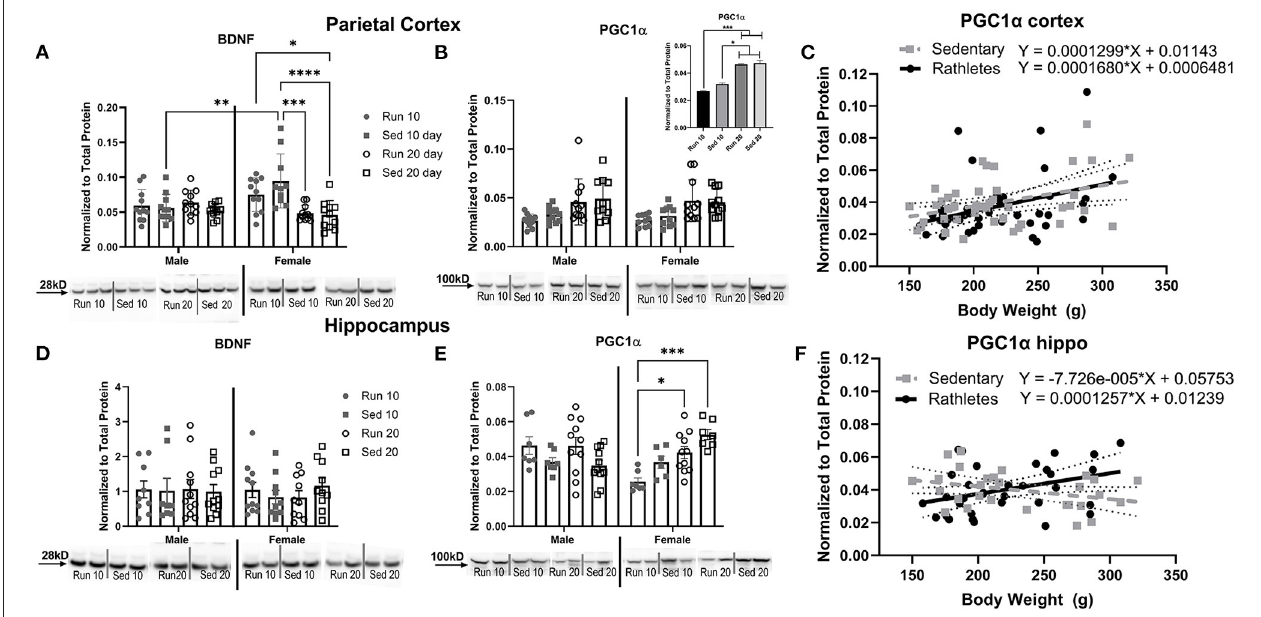
FIGURE 6 | Protein Expression in Brain. A Western blot was used to determine levels of (A) BDNF and (B) PGC1 α in the parietal cortex. Acute (10 day) and chronic (20 day) changes in protein expression were compared between rathletes (“Run”) and sedentary (“Sed”) rats between these time points. Sex differences were also analyzed. Where sex differences were not present, males and females were combined ( B , inset). A correlation and linear regression were analyzed between body weight and density of PGC1 α in the (C) cortex. Density of specific bands were normalized to total protein by Sypro Ruby staining (see Supplementary Figure 1 ). Hippocampal expression of BDNF (D) and PGC1 α (E) was also determined, as well as correlations in body weight to PGC1 α (F) . For correlations, males and females were combined within the rathlete and sedentary groups. Significant regressions were found for rathletes in the cortex ( p = 0.02) and hippocampus ( p = 0.04). Significance was only found for the sedentary group in the cortex ( p = 0.02), but not hippocampus ( p = 0.08). Run 10 = voluntary running wheels for 10 days ( n = 14/sex), Sed 10 = locked wheels for 10 days ( n = 14/sex), Run 20 = voluntary running for 10 days then rested in homecage 10 days ( n = 14/sex), Sed 20 = locked wheels for 10 days then rested in homecage for 10 days ( n = 14/sex). Data are presented as average ± SEM. * p < 0.05, ** p < 0.01, *** p < 0.001, **** p <